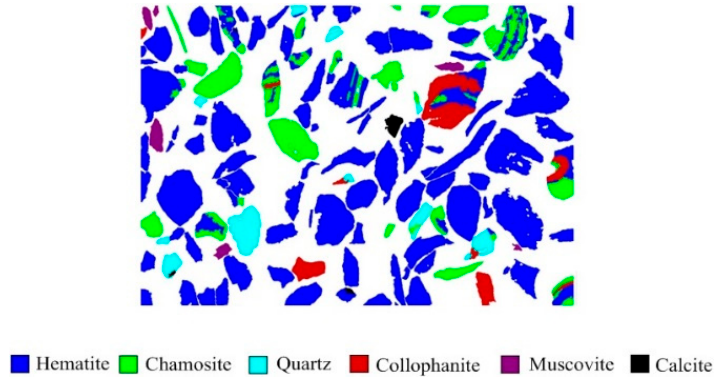
Figure 2. The mineral liberation analyser (MLA) automatic detection image of the ore sample.